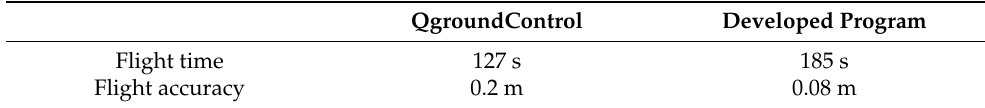
Figure 22. Comparison of commercial and developed program flight trajectories. Table 6. Comparison of simulation and actual field